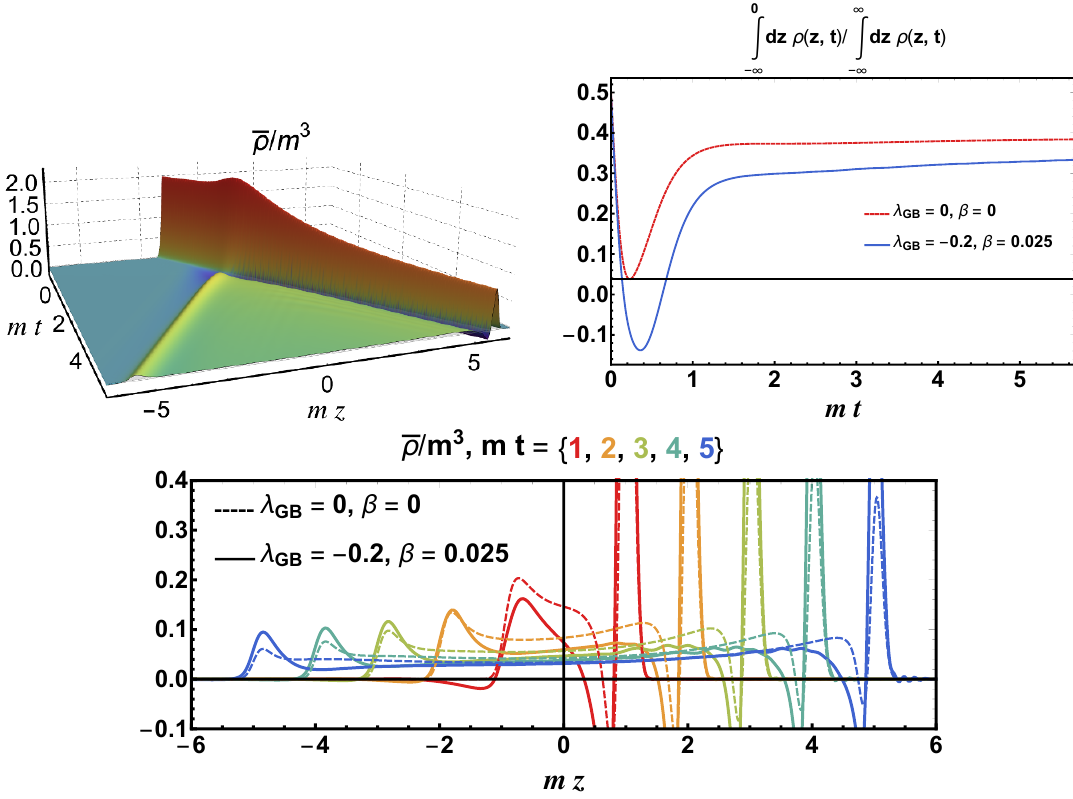
Figure 12 . The upper-left panel shows the baryon number distribution in the collision of two thin sheets, only one of which (the one incident from z < 0) carries baryon number. The calculation is done at (cid:21) = (cid:0) 0 : 2, (cid:12) = 0 : 025. Relative to what we saw in (cid:12)gure 2 when both incident sheets GB carried baryon number, the peak in the baryon number density near z = t = 0 is much smaller here. The absence of the large peak near z = t = 0 is not surprising, since when both sheets carry baryon number this comes directly from summing the two original sheets, but the presence of the small peak here as well as the charge density on the negative-moving lightcone indicates that the sheet of energy density that comes in at the speed of light carrying no baryon number immediately obtains some baryon number from the other sheet. Initially, at mt = 1 this e(cid:11)ect is stronger at in(cid:12)nite coupling (see lower panel), but at later times there is more charge on the lightcone for the collision done with nonzero (cid:21) and (cid:12) , due to the weaker coupling. The amount of baryon number GB that ends up going through the collision zone and staying near the positive-going lightcone at late times is however almost the same as in the case of two colliding charged sheets. In the lower panel, we look at the time evolution of the baryon number density distribution at (cid:12)ve time slices. In the upper-right panel, we compute the fraction of the baryon number that has been re(cid:13)ected (which is to say that is at z < 0 after t = 0) as a function of time for (cid:21) = (cid:0) 0 : 2, (cid:12) = 0 : 025 compared to GB the in(cid:12)nite coupling case, (cid:21) = (cid:12) = 0. GB